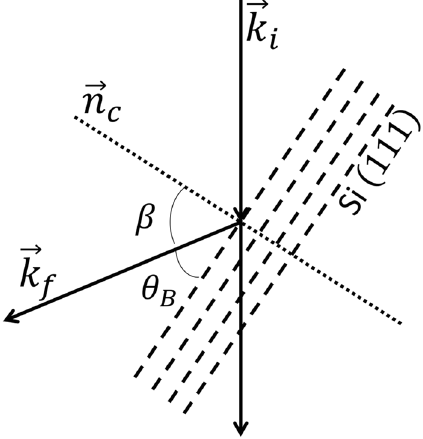
Figure 2. The schematic of the scattering from Si (111) planes, where 2 θ B = 46.6° at k i = 2.55 Å − 1 for a neutron wavelength of 2.46